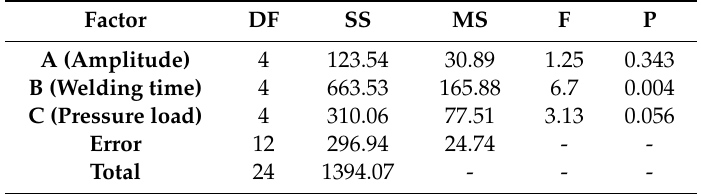
Table 4. ANOVA (Analysis of Variance) for the signal to noise ratio (S / N) ratio of shearing strength.